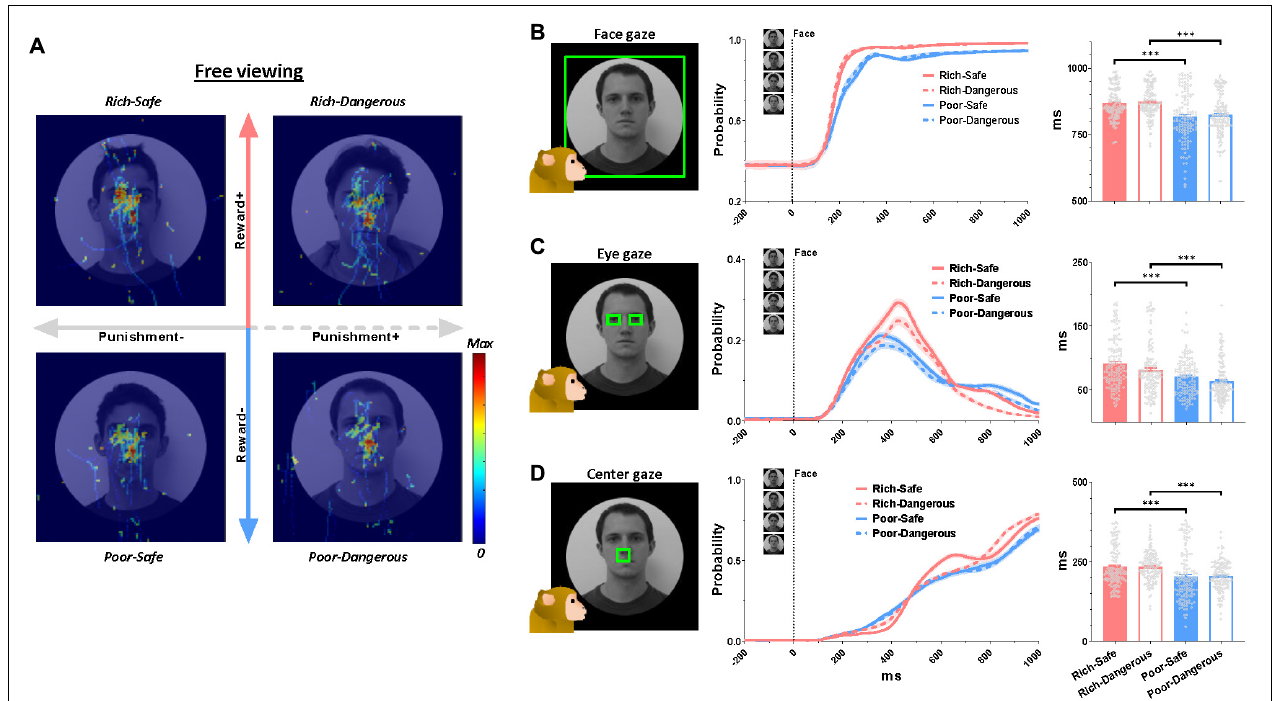
FIGURE 2 | Eye gaze to high- and low-valued faces. (A) Normalized eye scan patterns during the free viewing period. Hot colors indicate higher gaze probability. (B–D) Left, green boxes indicate regions of interest. Middle, probability of gaze within the said region over all trials ever recorded in the active and passive conditions during the entirety of 138 behavioral sessions. Right, quantification of gaze on the face regions. The average duration of gaze inside the region of interest inside the following time windows: gaze on the face, 0-1,000 ms (top row), gaze at eyes, 0-1,000 ms (middle row), gaze at screen center, 600-1,000 ms (bottom row). Data were from both monkeys and all behaviors averaged across entire